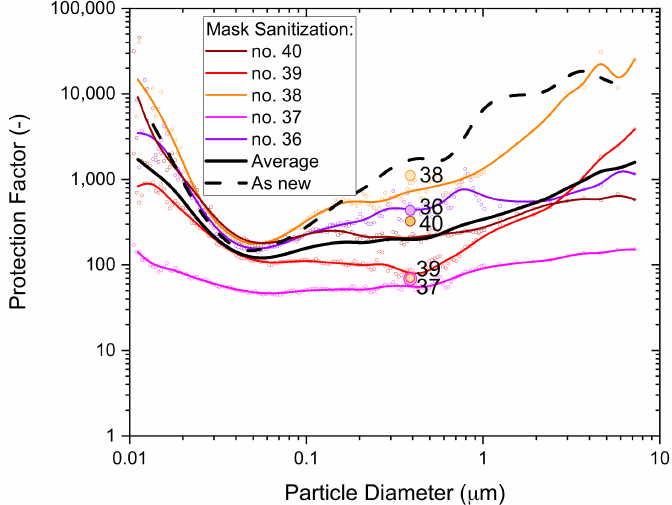
Figure 15. The particle size dependence of the protection factor of five P2-SD disposable respirator masks (Shanghai Da Sheng, box 3) after exposure to mask sanitization application of 70% IPA solution; results from non-destructive testing are shown as circular dots with corresponding coloring at 0.39 µ m particle size. The average performance is shown by the black solid line and the performance of an unused mask (as new) is shown for comparison by the black dashed